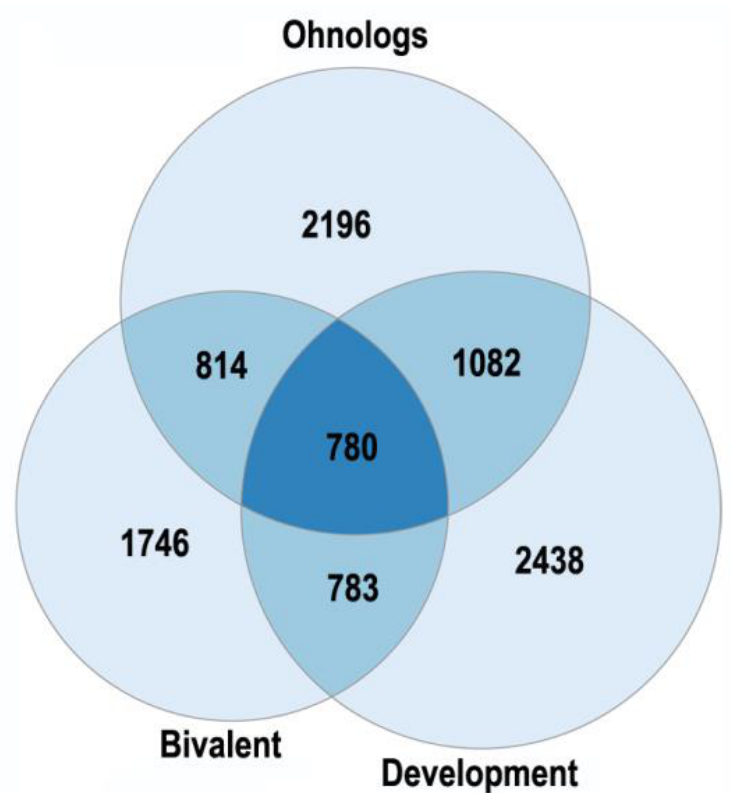
Figure 1. The enrichment of human ohnologs in bivalent genes and genes involved in multicellular organism development GO:0007275. Bivalent: p < 10 − 151 , development: p < 10 − 67 . The ohnologs (strict) were from [14]. The bivalent genes (Fantom-confirmed) were from [30]. The enrichment analysis was conducted as in [32].